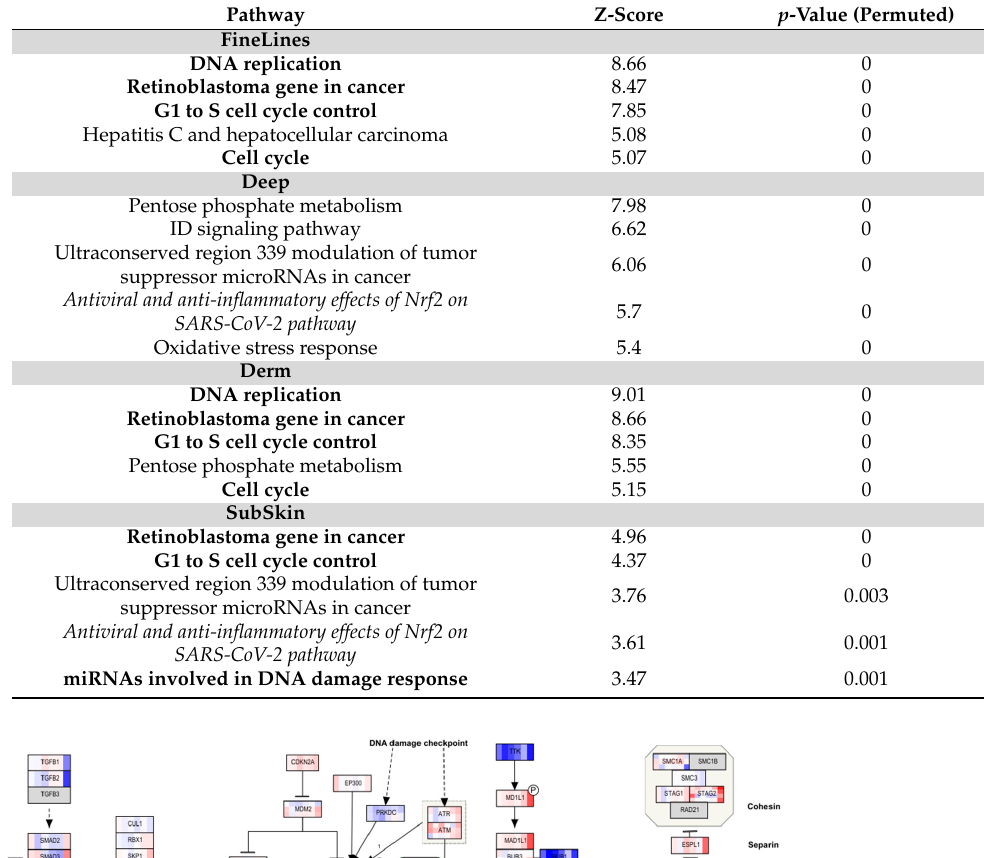
Table 6. Top 5 significant pathways for M0 macrophages derived from THP-1 cells exposed to Perfectha ® filler extracts. DEGs selected by moderated t -test with adjusted p -value < 0.05 were used for pathway analysis in PathVisio. Pathways related to cell cycle control and those related to immune and inflammatory responses are shown in bold and in italics, respectively.